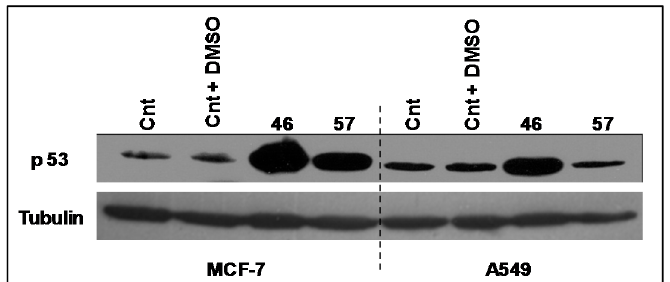
Figure 8. Changes in the expression of p53 in A549 and MCF-7 cells induced by extracts #57 and #46. Extract #57 increases the expression of p53 exclusively in MCF-7 cells. Tubulin has been used as loading control.